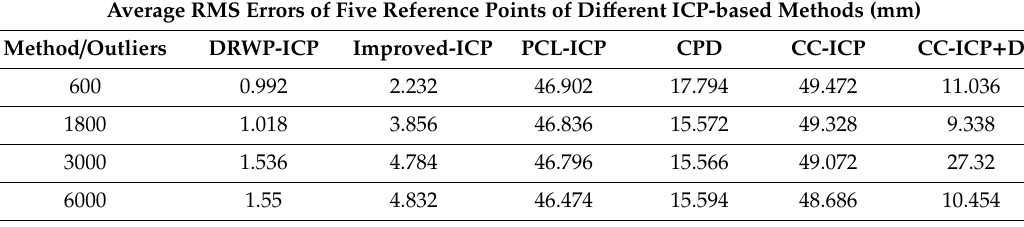
Table 5. The Average, Minimum and Maximum of Reference Points’ Alignment Errors.